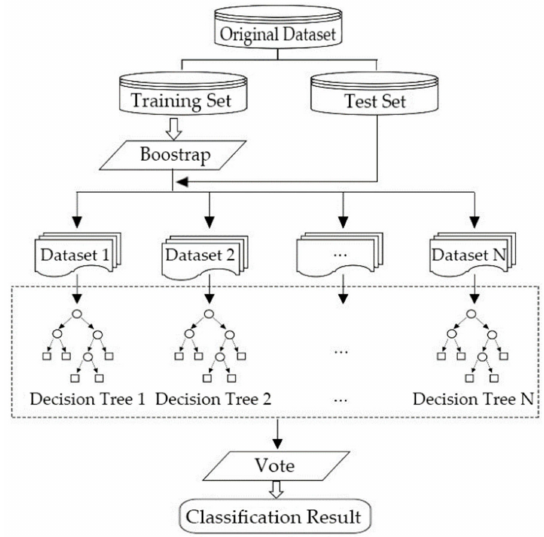
Figure 2. Architecture of the Random Forest algorithm.